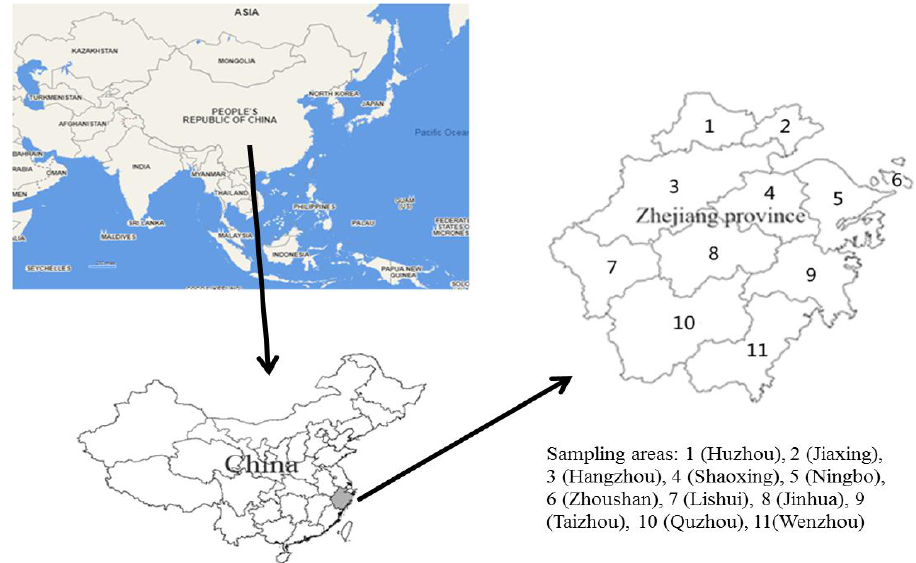
Figure 1. The simple map of sampling areas in Zhejiang province, southeast China.